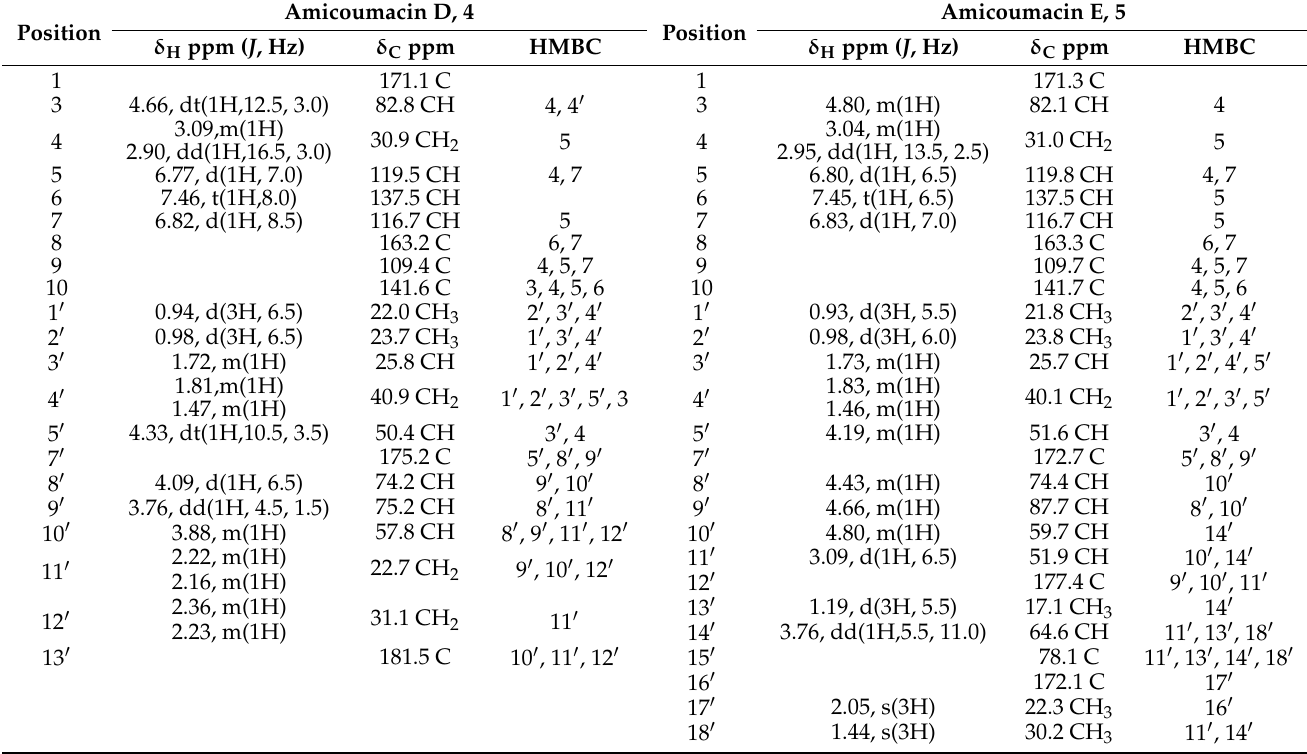
Table 2. 1 H NMR ( J in Hz), 13 C NMR spectral data of amicoumacin D, 4 , and E, 5 , in methanol- d 4